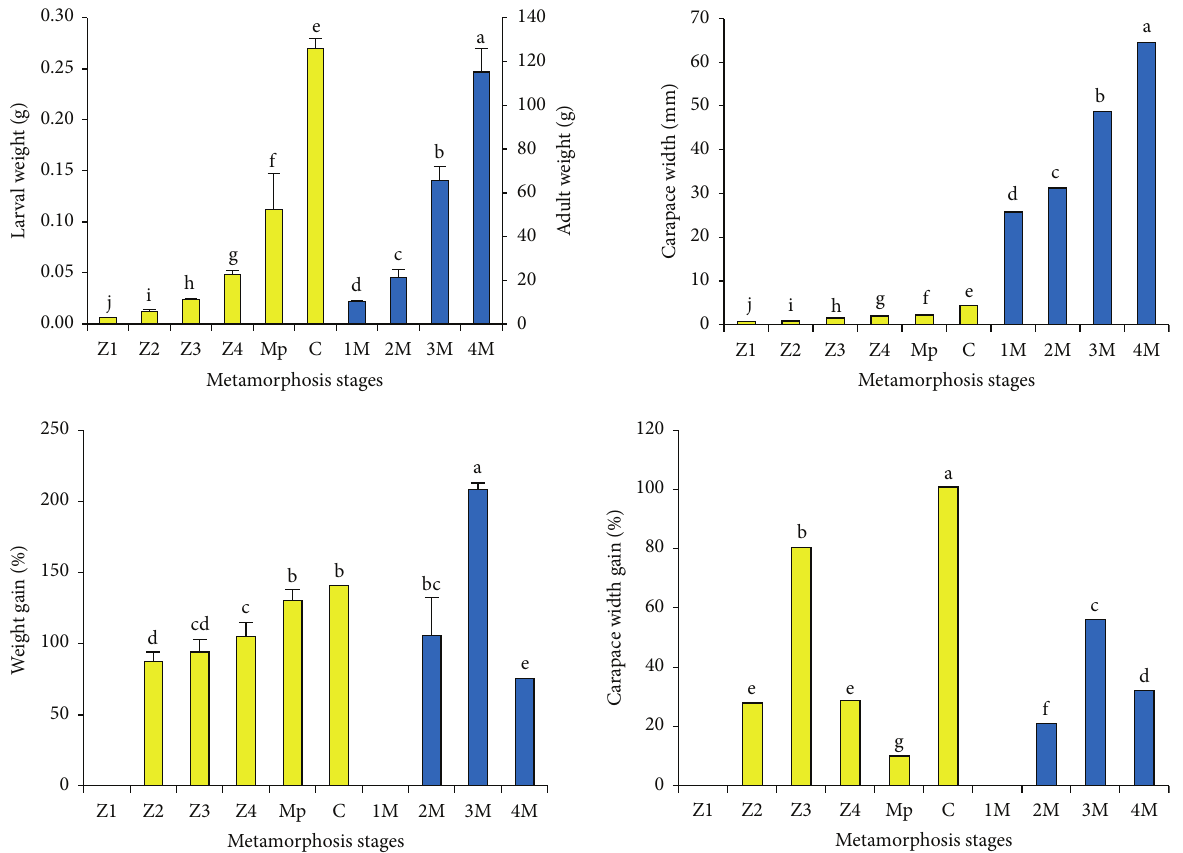
Figure 1: Growth in weight and carapace width of P. pelagicus during metamorphosis, at different larval stages (zoea, Z1–Z4; megalopa, Mp; first crab, C) and different adult stages (1M–4M). Vertical bars indicate ± SEM ( 𝑛 = 3–5). Interval % gain of weight and carapace width could not be calculated at 1M stage because no measurement was performed prior to this stage. The bars with different superscripts are significantly different ( 𝑃 < 0.05 ).